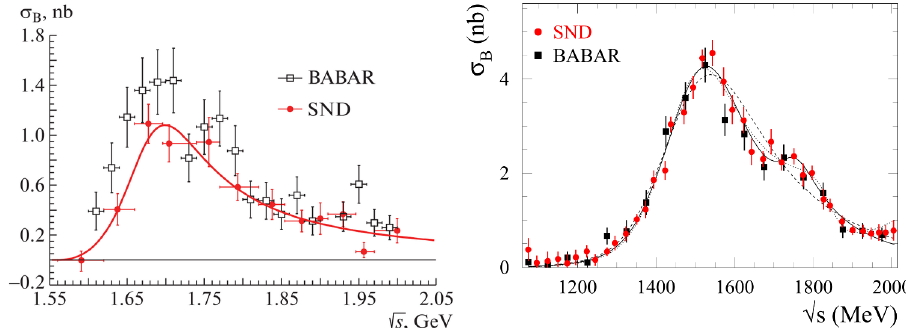
Figure 6. The e + e − → ηπ + π − cross section measured by SND and BABAR [17]. The solid, dashed, and dotted curves are the results of the VMD fit with 2, 3 and 4 ρ -like